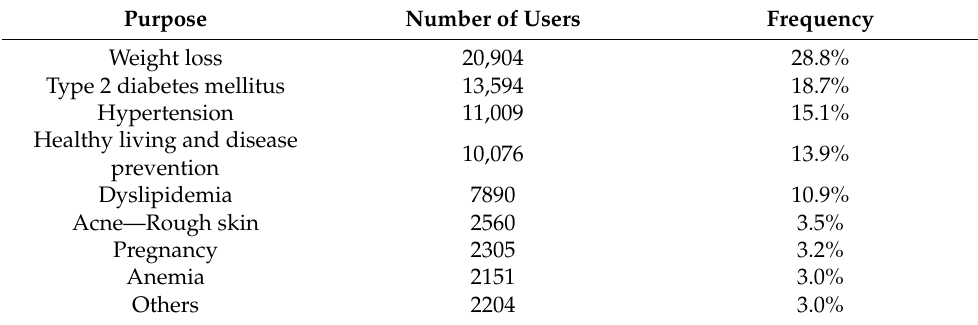
Table 2. Purposes for using the application of 72,693 users.